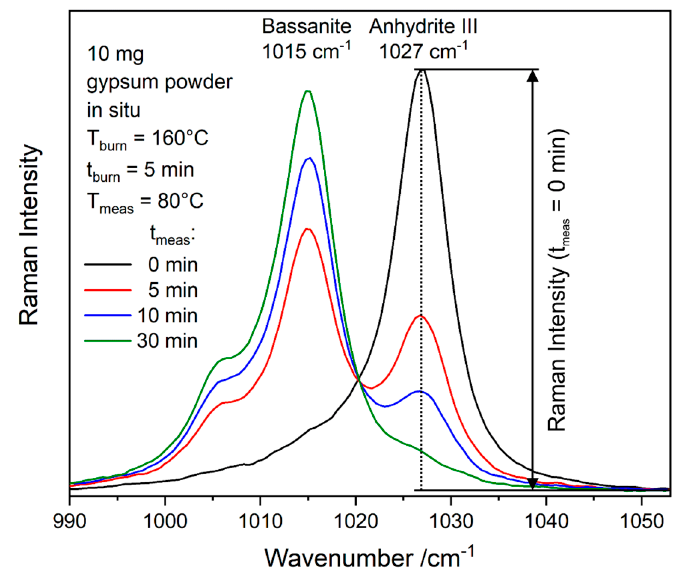
Figure 14. Raman spectra measured in situ after exposing anhydrite III to ambient air at 80 °C. Anhydrite III was synthesised by burning of 10 mg gypsum powder at 160 °C (t burn = 5 min).